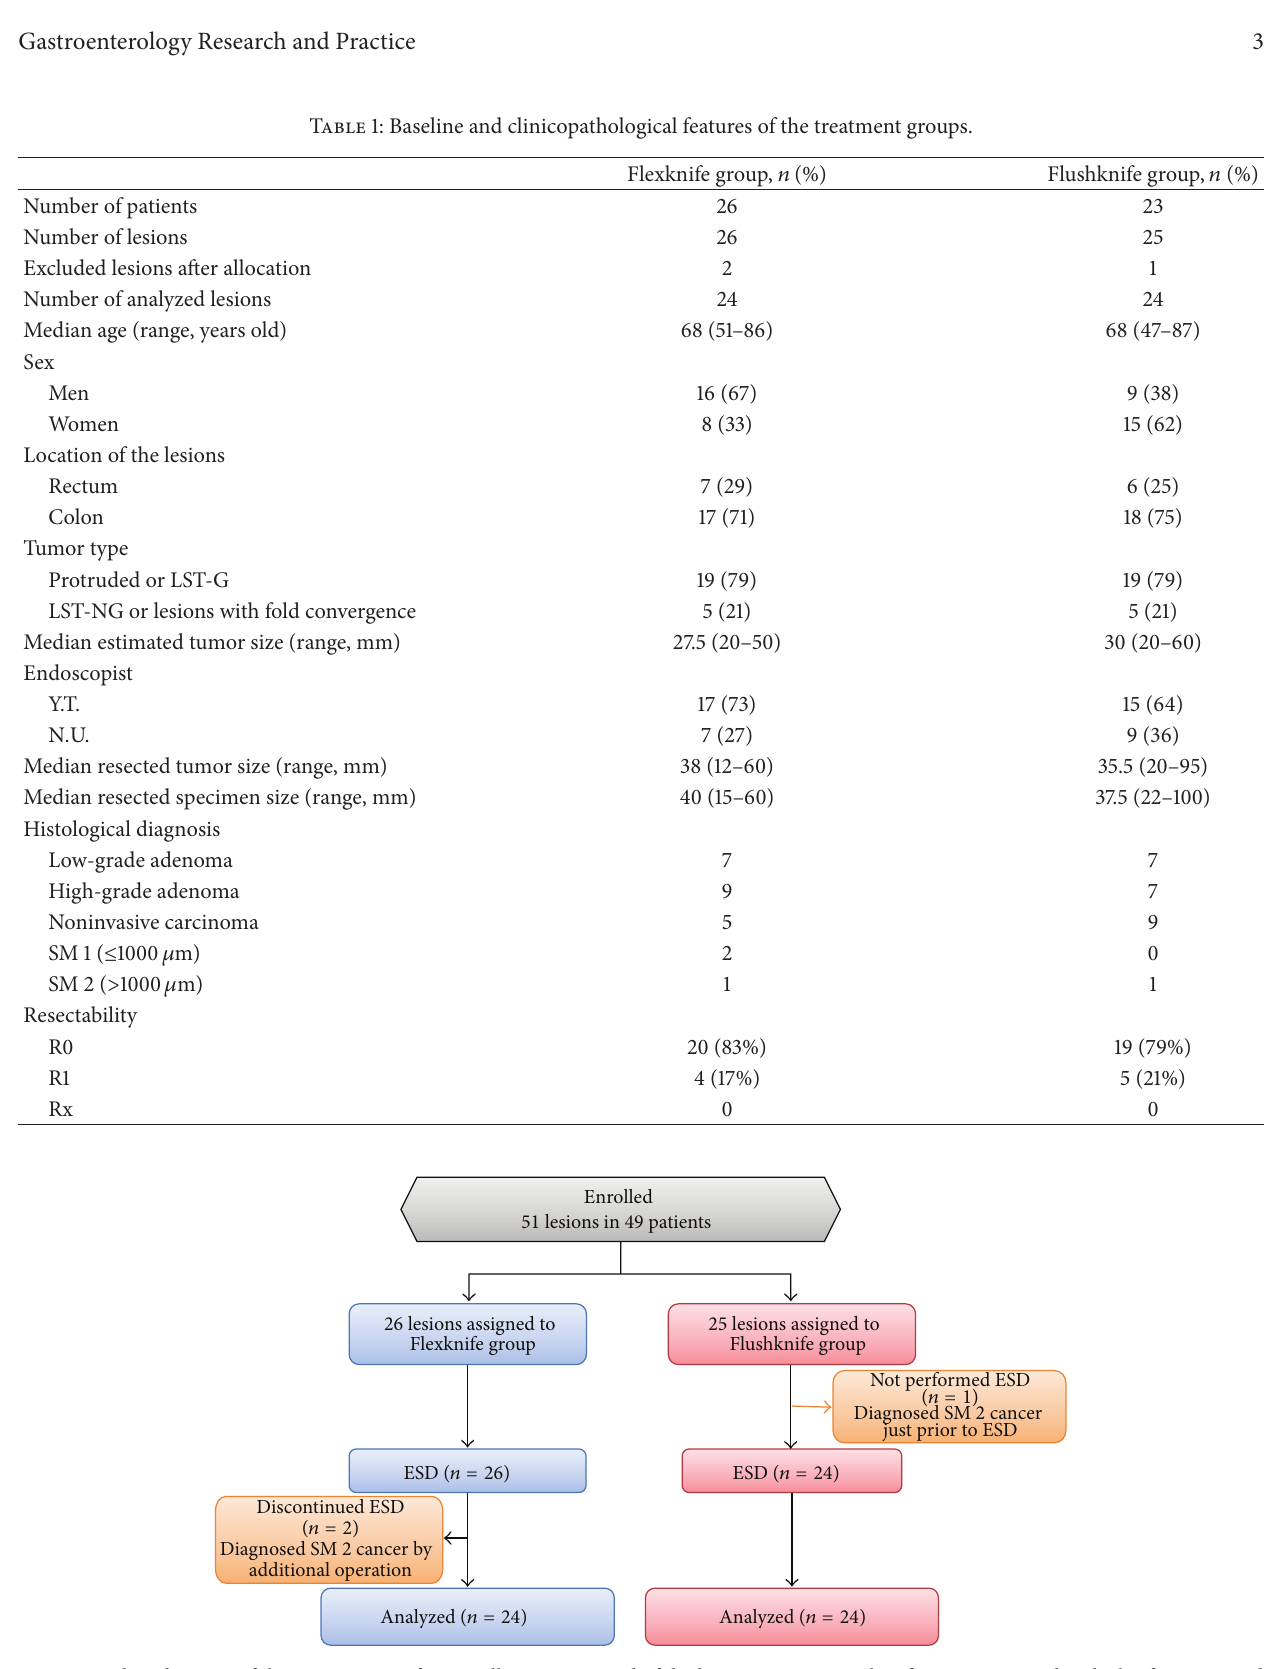
Figure 2: Flow diagram of the participants after enrollment. Removal of the lesions was incomplete for two cases in the Flexknife group, and one lesion removal procedure was not performed in the Flushknife group. Thus, 24 lesions in each group were completed and analyzed in this